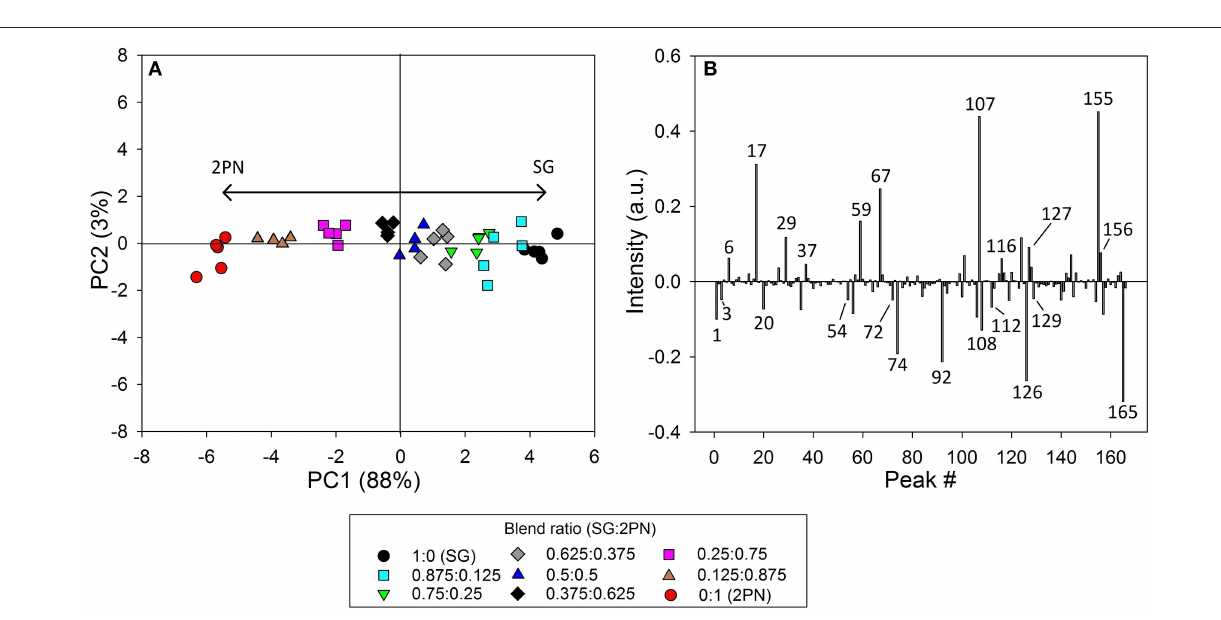
Frontiers in Energy Research |